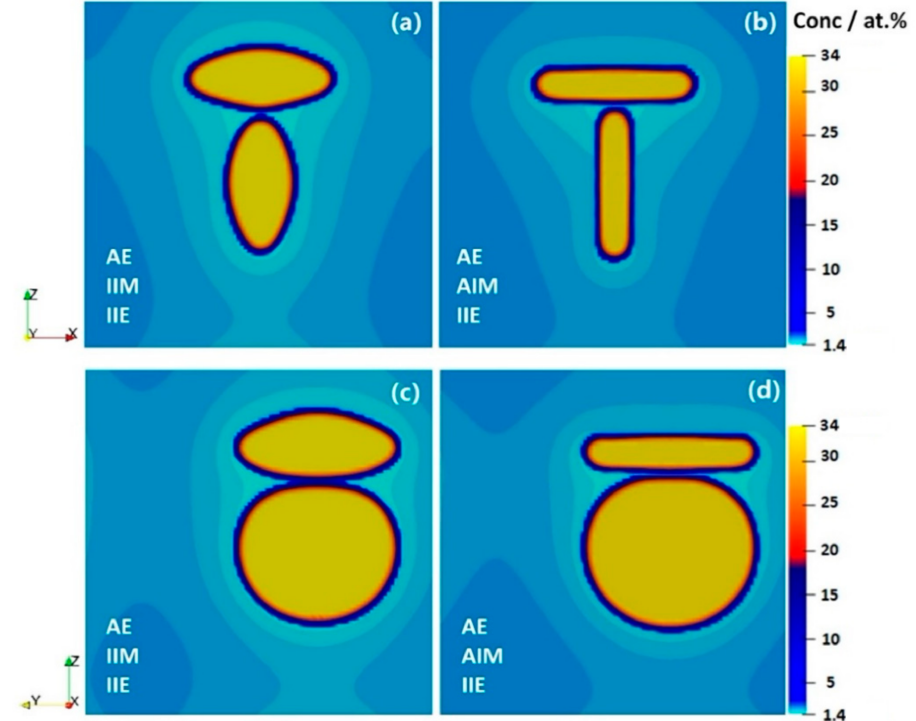
Figure 8. 2D-cross section of phase-field simulated concentration fields of two perpendicular precipi- tates with ( a , c ) AE, IIM and IIE conditions and ( b , d ) AE, AIM and IIE conditions in Al-1.69 at.% Cu alloy annealed at 453 K for t = 15,000 s, along different directions. Here a 100 × 100 × 100 domain with grid spacing of ∆ x = 0.7 is